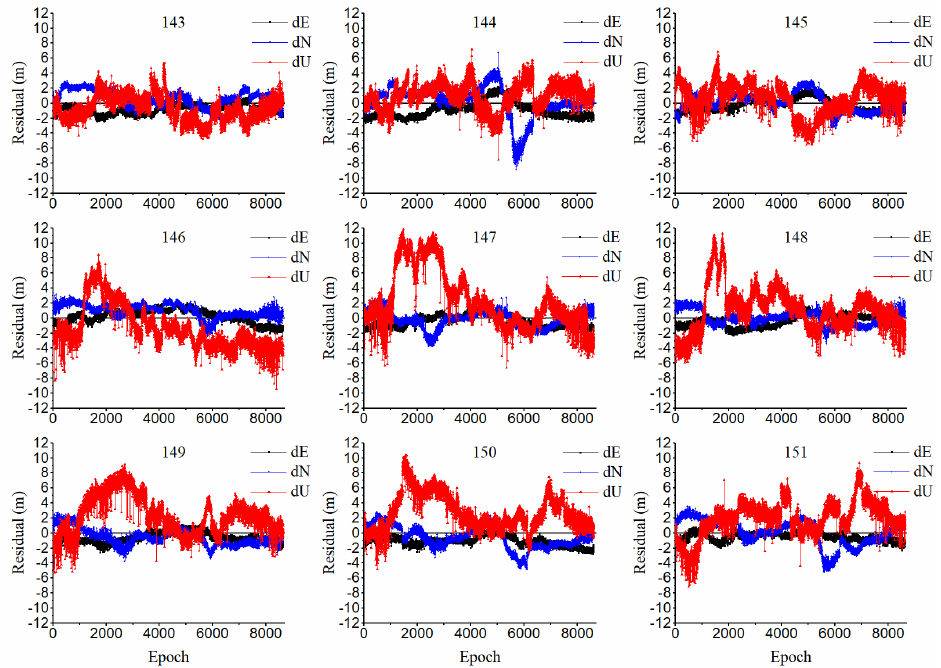
Figure 11. Positioning residuals of SPP with BDS code measurements. Table 2. Position residuals of single-point positioning (SPP) with GPS and BeiDou